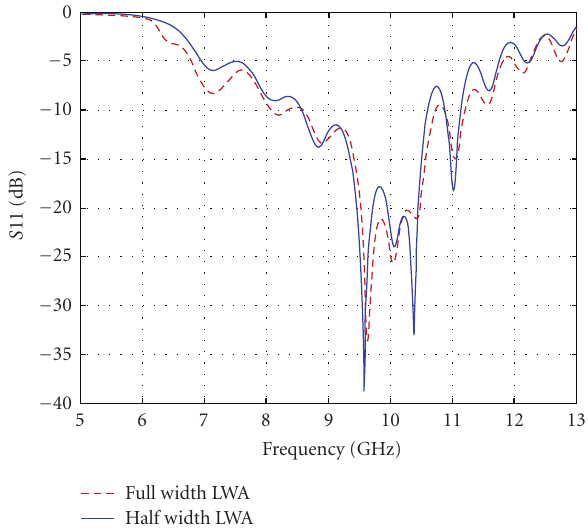
Figure 7: Simulated return loss (S11) of tapered LWA (Type II) and half tapered LWA (Type III) obtained by 3D electromagnetic simulator.